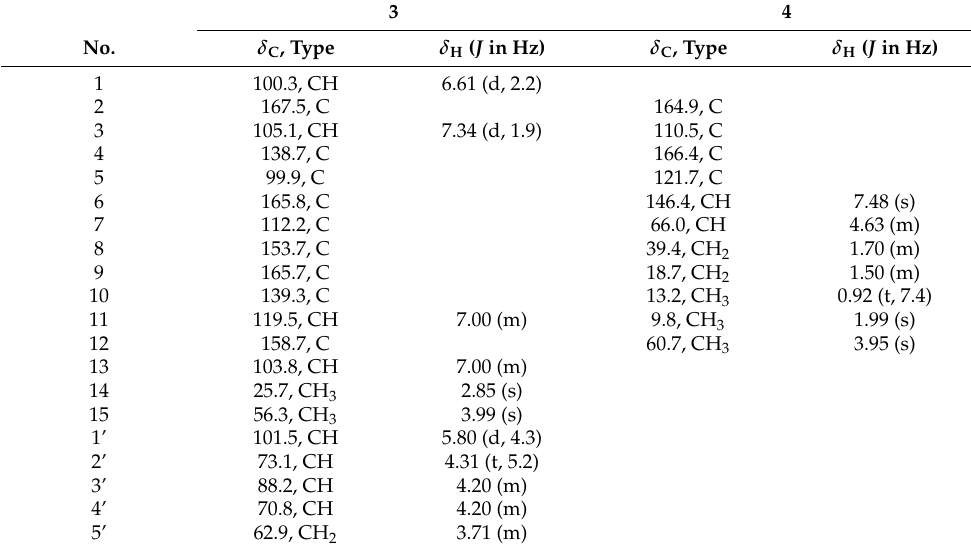
Table 2. 1 H NMR (600 MHz) and 13 C NMR (150 MHz) spectral data of 3 and 4 in acetone- d 6 .